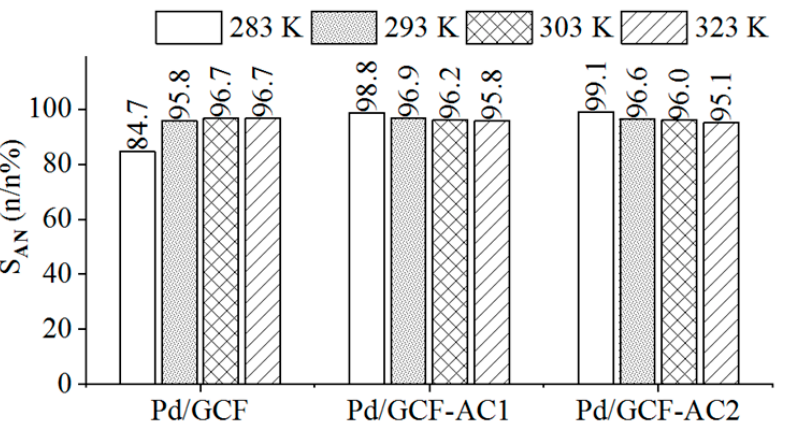
Figure 9. Selectivity of aniline on the Pd/GCF, Pd/GCF-AC1, and the Pd/GCF-AC2 catalyst at different temperatures.